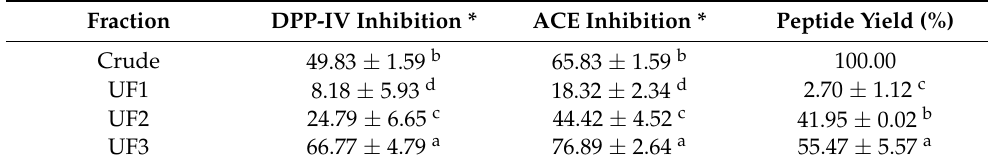
Table 1. DPP-IV and ACE inhibitory activities of sericin peptides derived from neutrase hydrolysis and peptide yields of ultrafiltration